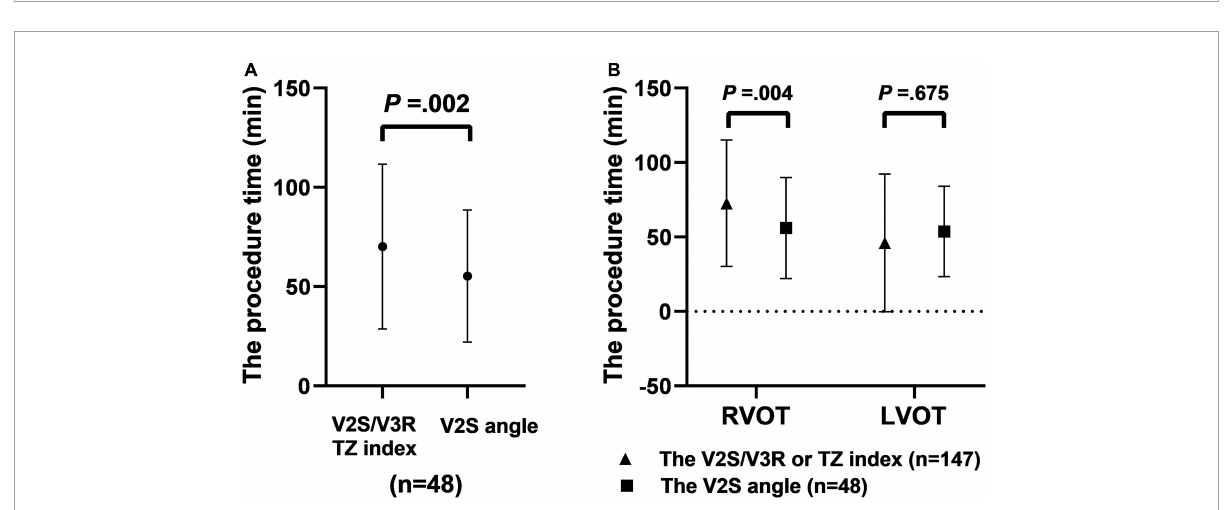
FIGURE7 The procedure time when using different diagnostic indexes made up of ECG criteria for predicting RVOT origin. The procedure time with the V2S angle was shorter than with V2S/V3R or the TZ index before RFCA in the prospective cohort ( n = 48) ( P = 0.002) (A) . The procedure time in the prospective cohort ( n = 48) with the V2S angle was shorter than that in the retrospective cohort ( n = 147) with V2S/V3R or the TZ index (B)